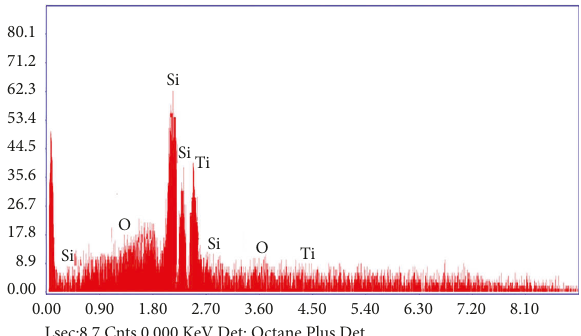
Figure 3: Energy dispersive X-ray analysis (EDAX) of B-IV sample coated solar